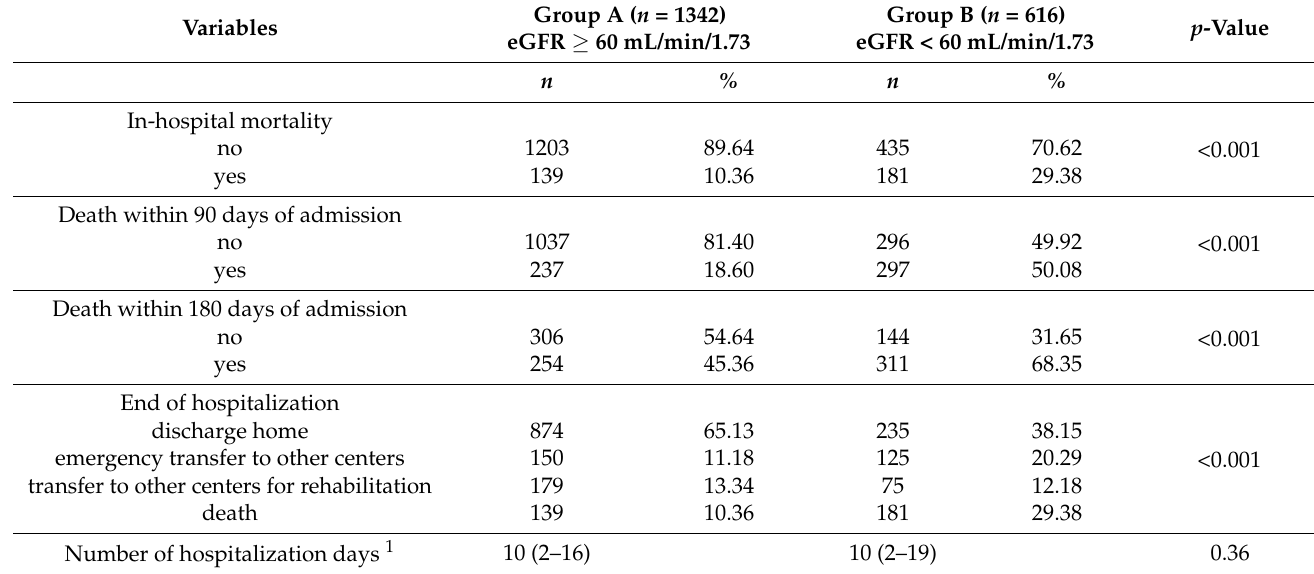
Table 7. Comparison of outcomes between two tested groups of COVID patients.